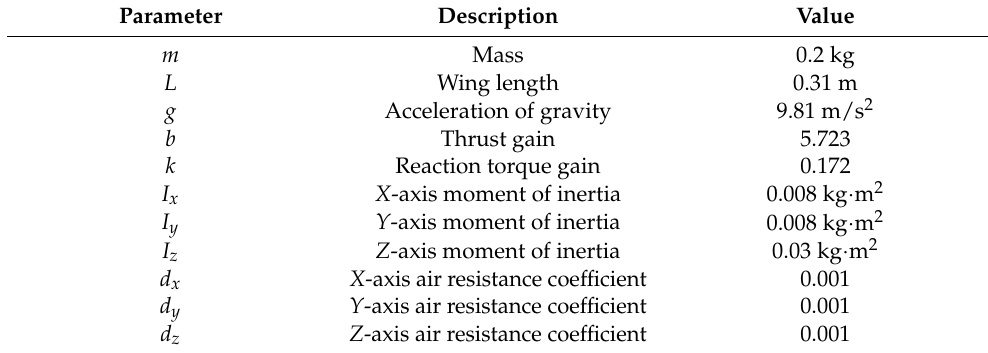
Table 1. Parameters of the Quadrotor